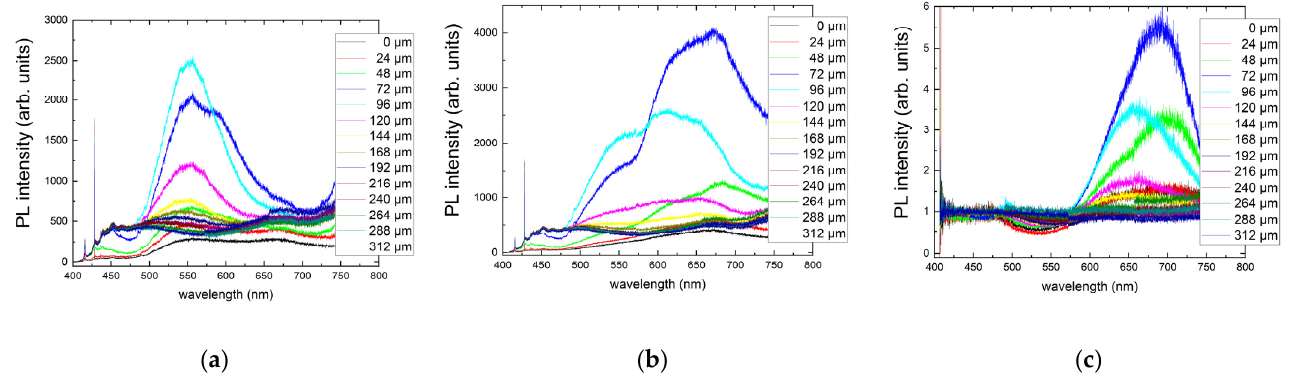
Figure 5. RT 405 nm excitation PL spectra of the background ( a ), micromarks ( b ), and their normal- ized intensity ( c ) at different depths inside the sample (frames) for an exposure time of 240 s (24 M pulses) and an incident 0.3 ps laser pulse energy of 1.6 μ J. Spectral assignment after [5].